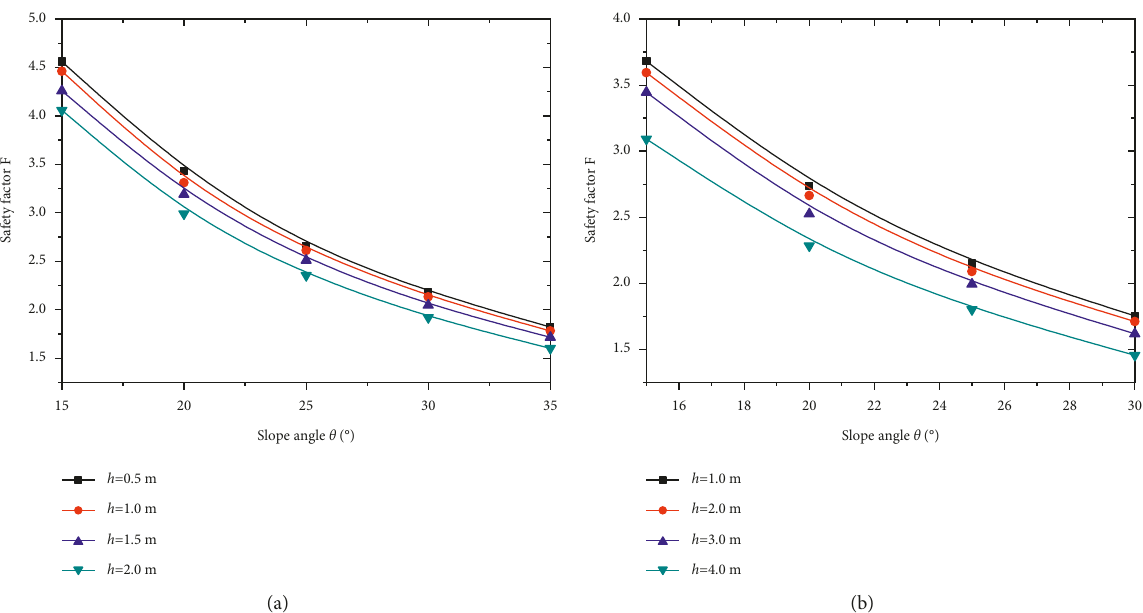
Figure 8: Effect of water level h and slope angle θ on safety factor. (a) Result of case 1 ( k